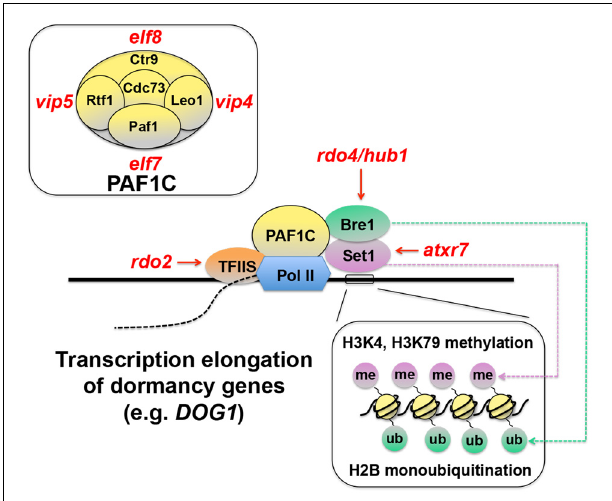
FIGURE 2 | Schematic representation of transcription elongation of seed dormancy genes. Transcription elongation factor S-II (TFIIS) assists RNA polymerase II (Pol II) and promotes transcription elongation (Saunders et al., 2006; Kim et al., 2010). Pol II-Associated Factor 1 Complex (PAF1C), which consists of Paf1, Rtf1, Ctr9, Leo1, and Cdc73 (top-left inset) in yeast (Porter et al., 2005), also functions in this process through its interaction with Bre1, which monoubiquitinates (ub) histone 2B (H2B), and Set1, which methylates (me) histone H3 lysine 4 (H3K4), and lysine 79 (H3K79) (bottom-right inset) (Sun and Allis, 2002; Zhu et al., 2005; Kim et al., 2009). These chromatin-remodeling events and their positive effects on transcription elongation are thought to be critical for induction of seed dormancy genes, because mutants in many of these components ( rdo2, rdo4, atxr7, elf 7, elf8, vip4, and vip5 ) exhibit reduced seed dormancy (Liu et al., 2011). Red italic symbols indicate Arabidopsis mutants corresponding to the yeast protein components. atxr7 , arabidopsis trithorax-related 7; elf , early flowering ; hub1 , h2b monoubiquitination1 ; rdo , reduced dormancy ; vip , vernalization independence